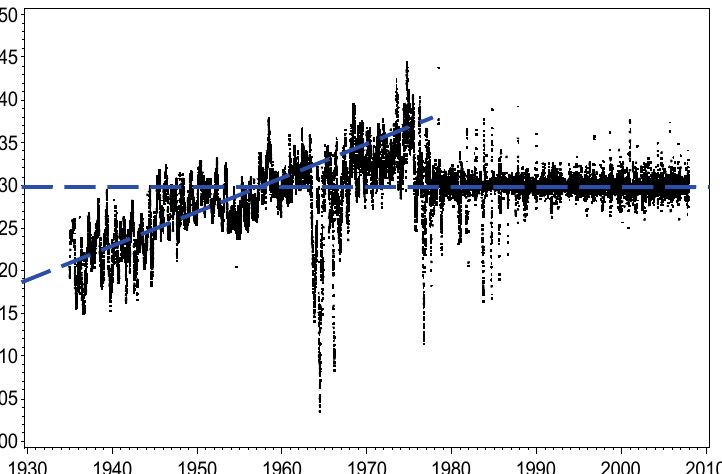
Fig. 2 Discharge ratio of the Atchafalaya distributary at Simmesport to the Mississippi River main channel at Tarbert